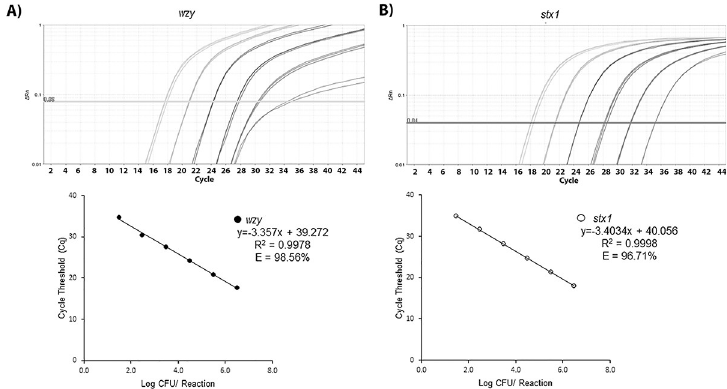
Fig 1. Determination of the detection limit of the qPCR assay. Calibration curves generated using 10-fold dilutions of DNA standards for E . coli EDL933_2 (top) detecting the wzy (A) and stx1 (B) genes. The Cq values were plotted against the log-scale CFU per reaction target concentration (bottom). The R 2 values and reaction efficiency (E) are also shown.